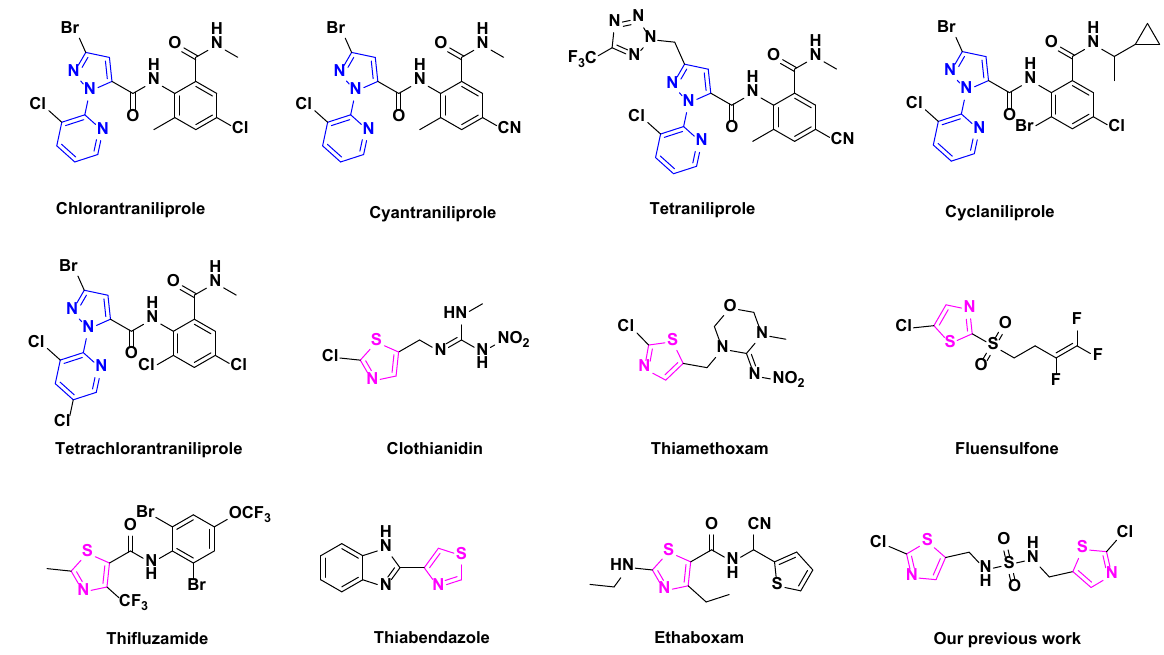
Figure 1. Chemical structures of representative compounds.